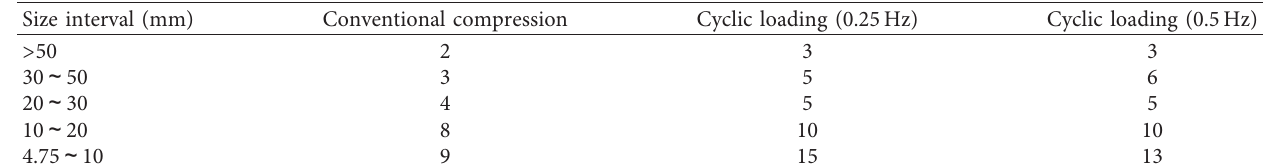
Table 4: Quantity distribution of limestone specimen fragments.